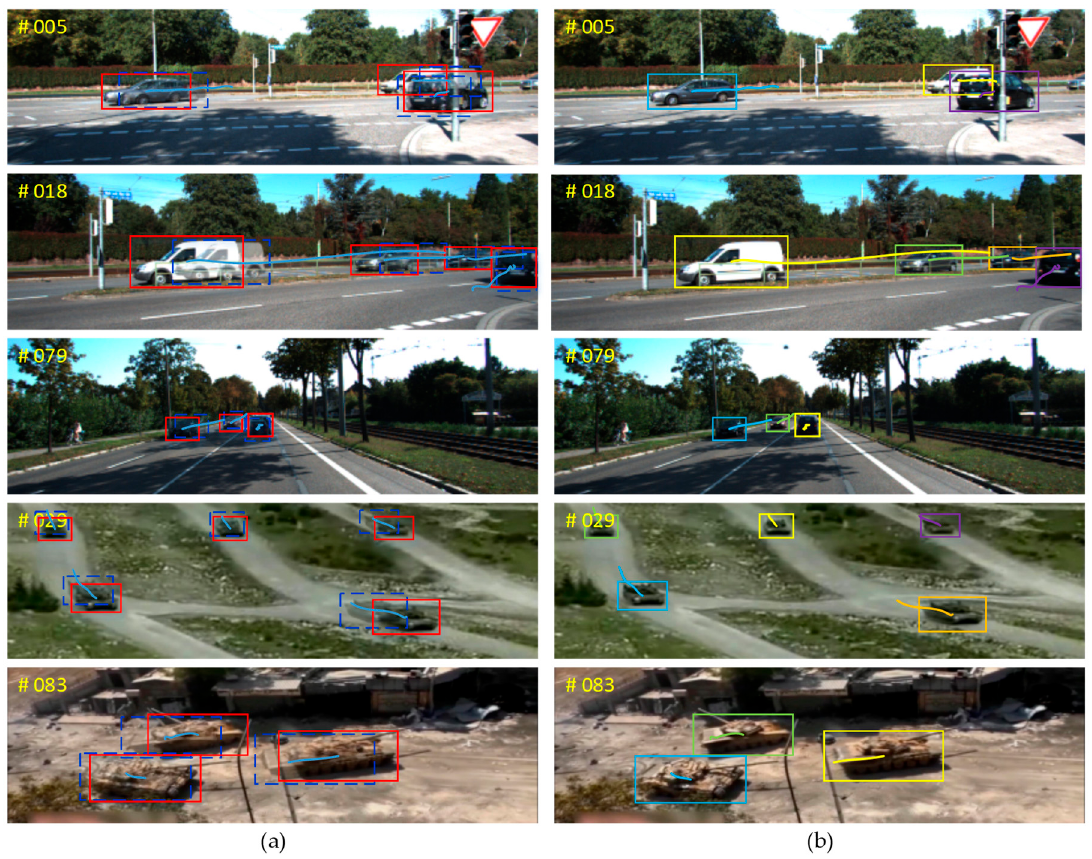
Figure 10. Experiment results using both the KITTI dataset and the ATTD. ( a ) Detection results with our Offline Candidates Recommendation Module. The previous position is denoted with a blue rectangle and the current with a red. ( b ) Tracking results using our MOT method and target trajectories.